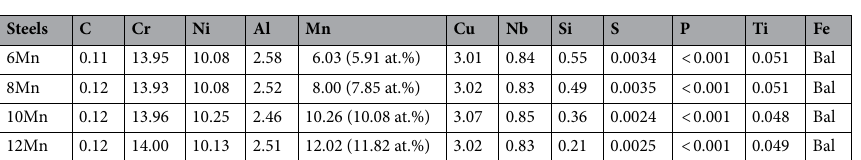
Table 1. The compositions of high-Mn AFA steel